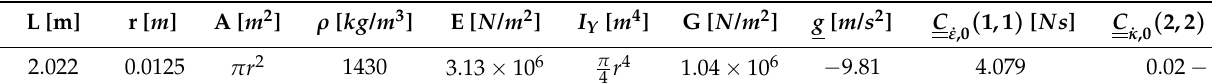
Table 6. Geometrical and material properties of the swinging elastic hanging rod.